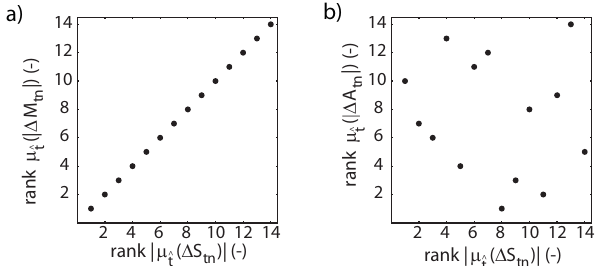
Fig. 9. Scatter plots of (a) the rank of absolute value of tempo- ( | 1M tn | ) ) vs. the rank of absolute values of temporal ral mean ( µ b t (1S tn ) | ) and (b) the mean difference of absolute soil moisture ( | µ b t rank of absolute values of temporal mean difference of absolute soil moisture vs the rank of temporal mean of absolute values of differ- ( | 1A tn | ) ). ences of anomalies ( µ b t Fig. 10. Average and standard deviation over the respective sites for each climatic region (M¨uller 1980), soil texture and elevation of (a) absolute soil moisture S tn and its decomposed (b) time-invariant (temporal mean) M tn and (c) time-varying (anomalies) A tn compo-